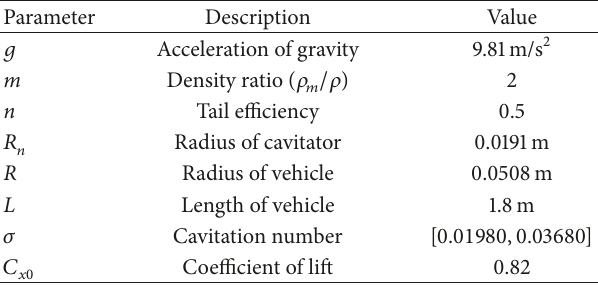
Table 1: Parameters of supercavitating vehicle model.